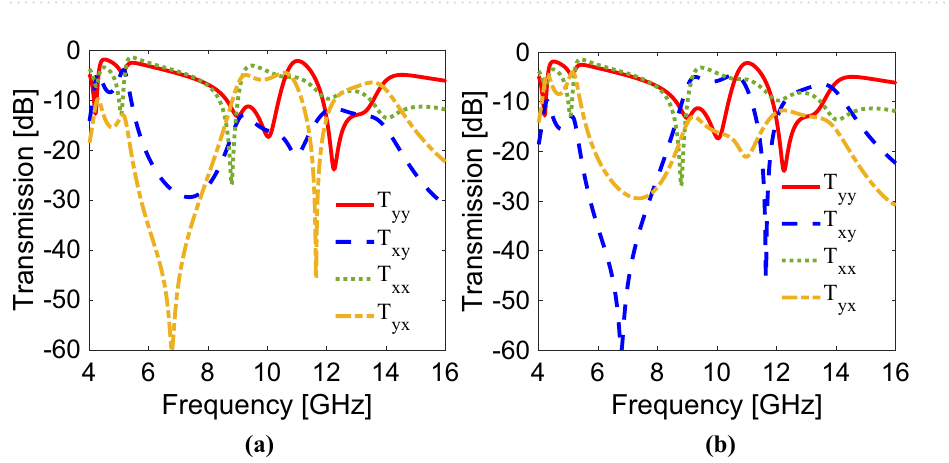
Figure 2. Magnitude of co- and cross-transmission components in ( a ) backward direction, ( b ) forward